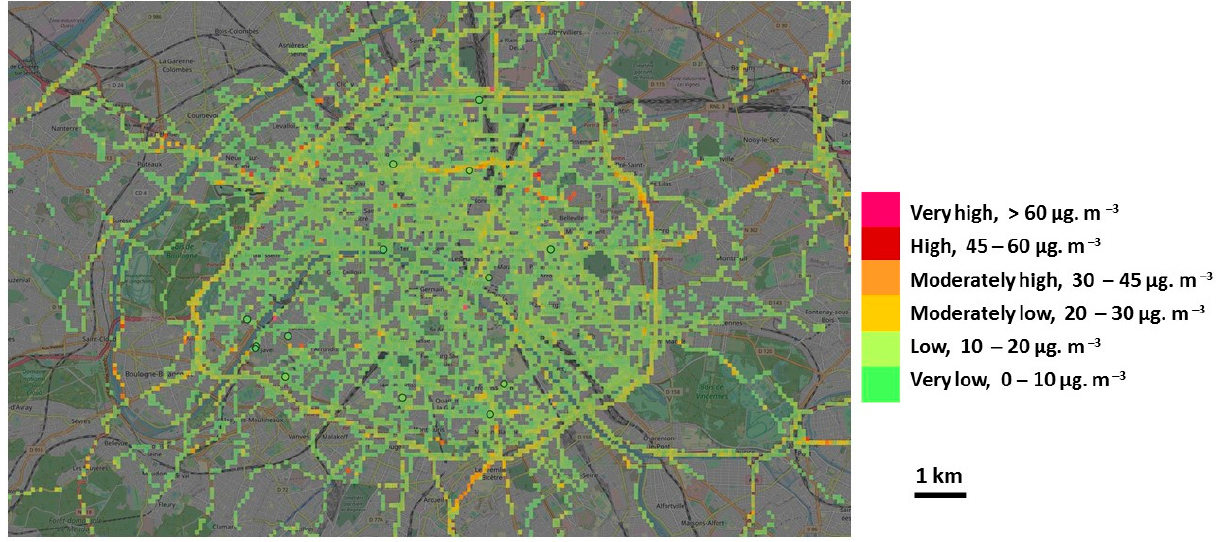
Figure 14. Pollution map in Paris for the 1 July 2020. North is up.